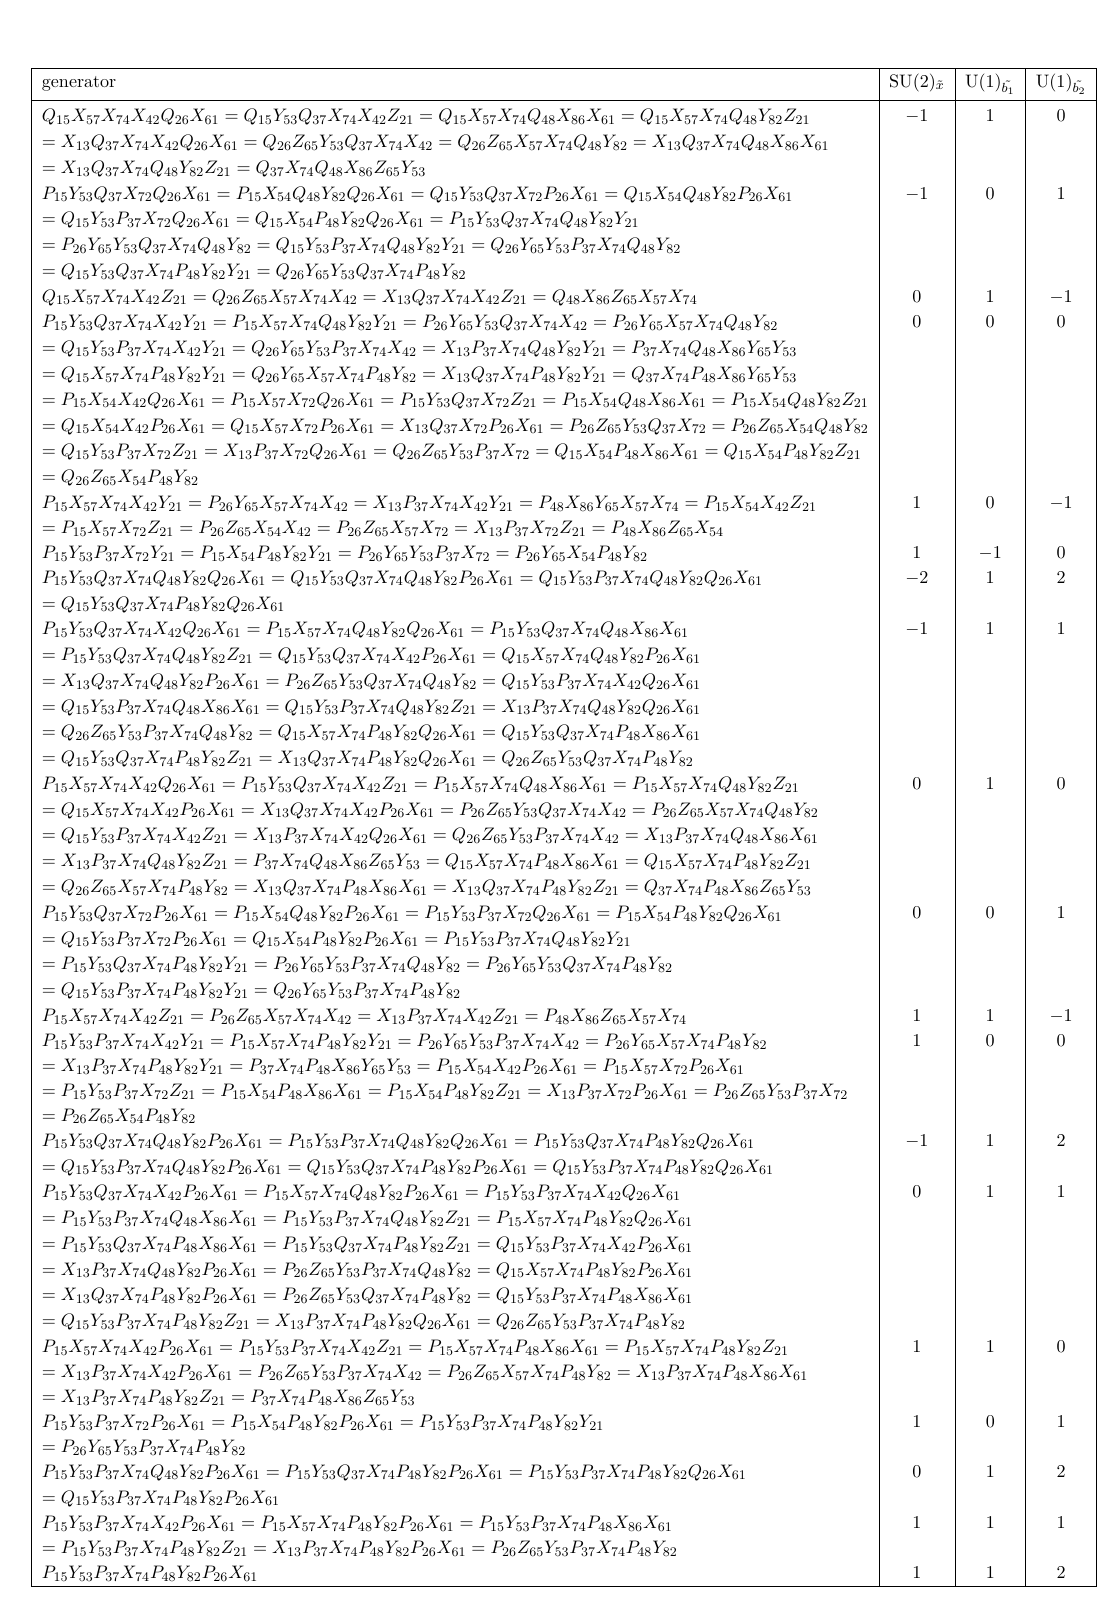
Table 42 . The generators in terms of bifundamental chiral fields for Model 10 (Part 2)